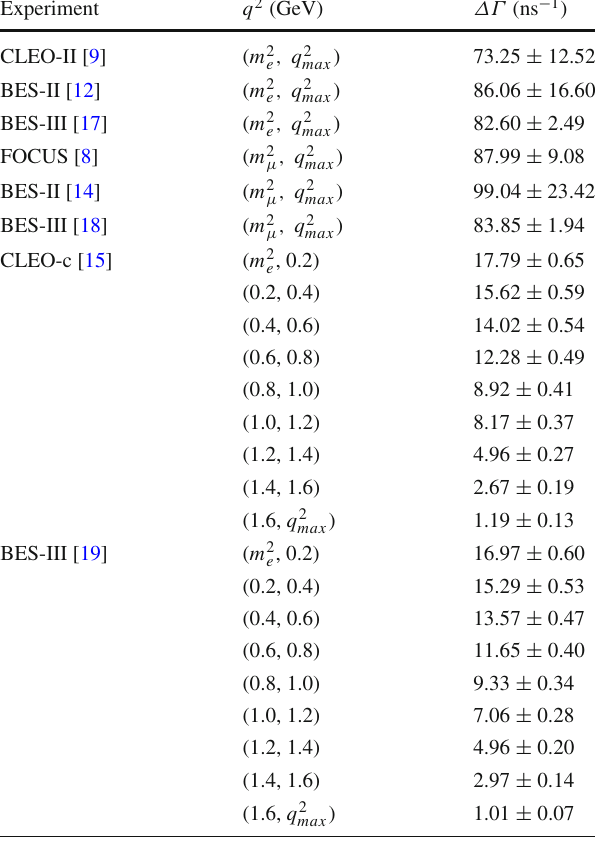
Table 3 Partial decay rates ΔΓ of D 0 → K − (cid:2) + ν (cid:2) decays in q 2 ranges Experiment